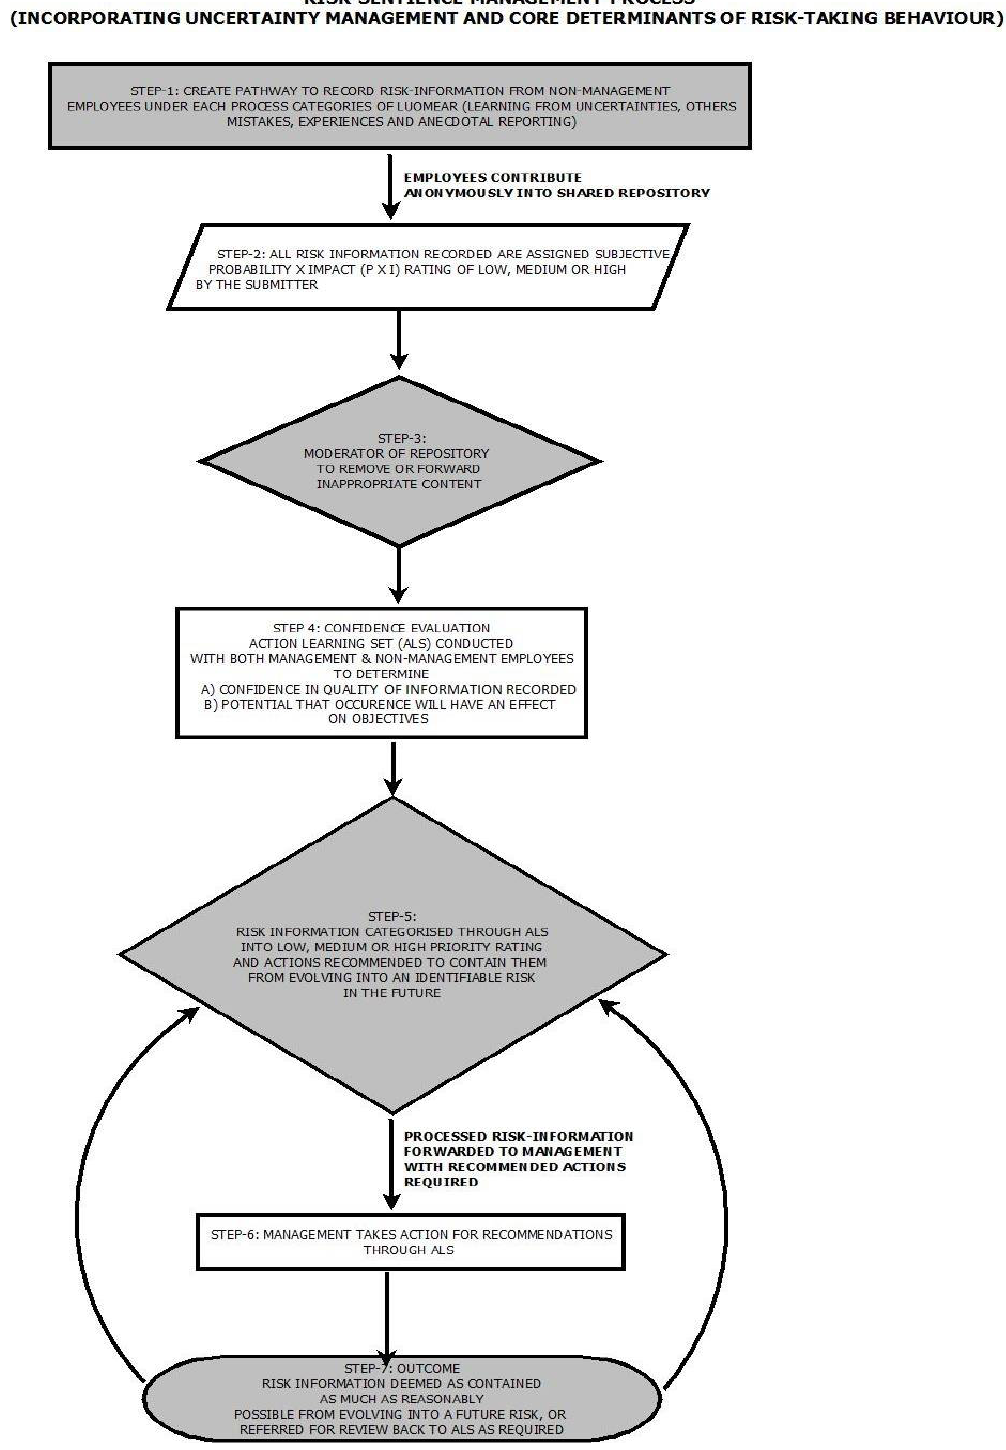
Figure 2. LUOMEAR—Risk-Sentience Management Process.